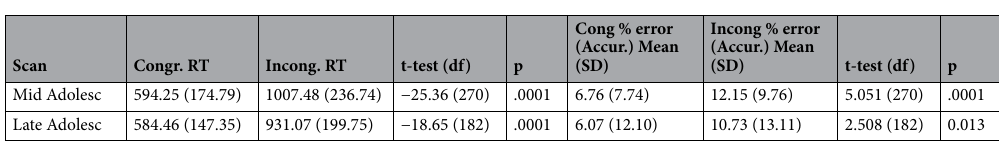
Table 2. Reaction time (RT) and accuracy scores for the congruent and incongruent trials in mid-adolescence and late-adolescence. See Fig. 4 for more information.